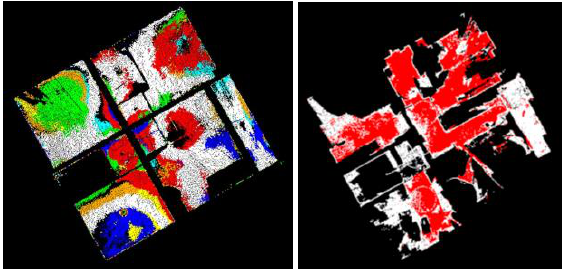
Figure 8. RANSAC segmentation of the entire storey (left The ceiling and right the floor).